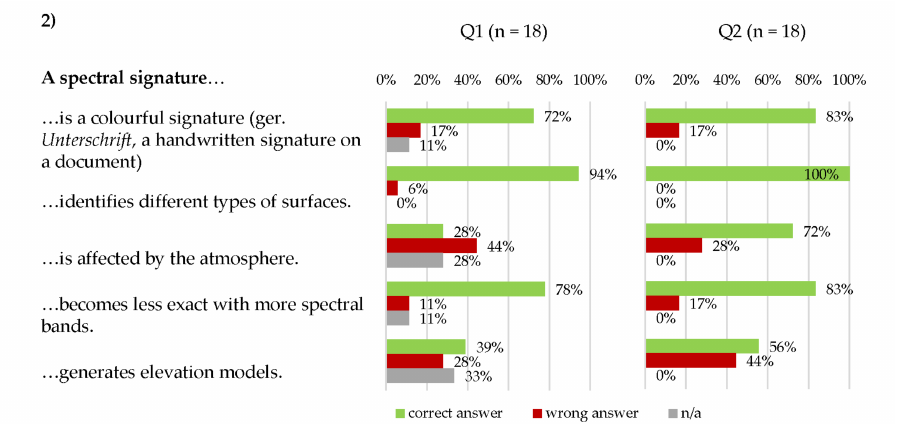
Figure 18. Answers from both test groups about the properties of spectral signatures.